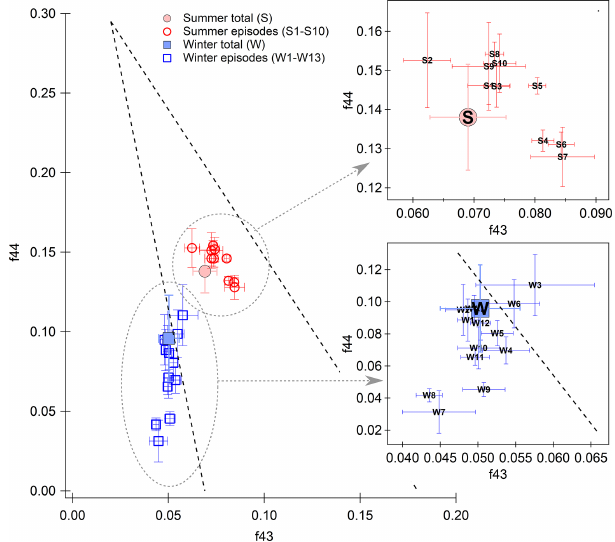
Figure 5. Comparison of organic fragments f 44 and f 43 for the whole summer and winter campaigns (full markers) and for specific episodes (empty markers). Bars represent the standard deviation and the triangular space area typical for ambient OOAs (Ng et al.,